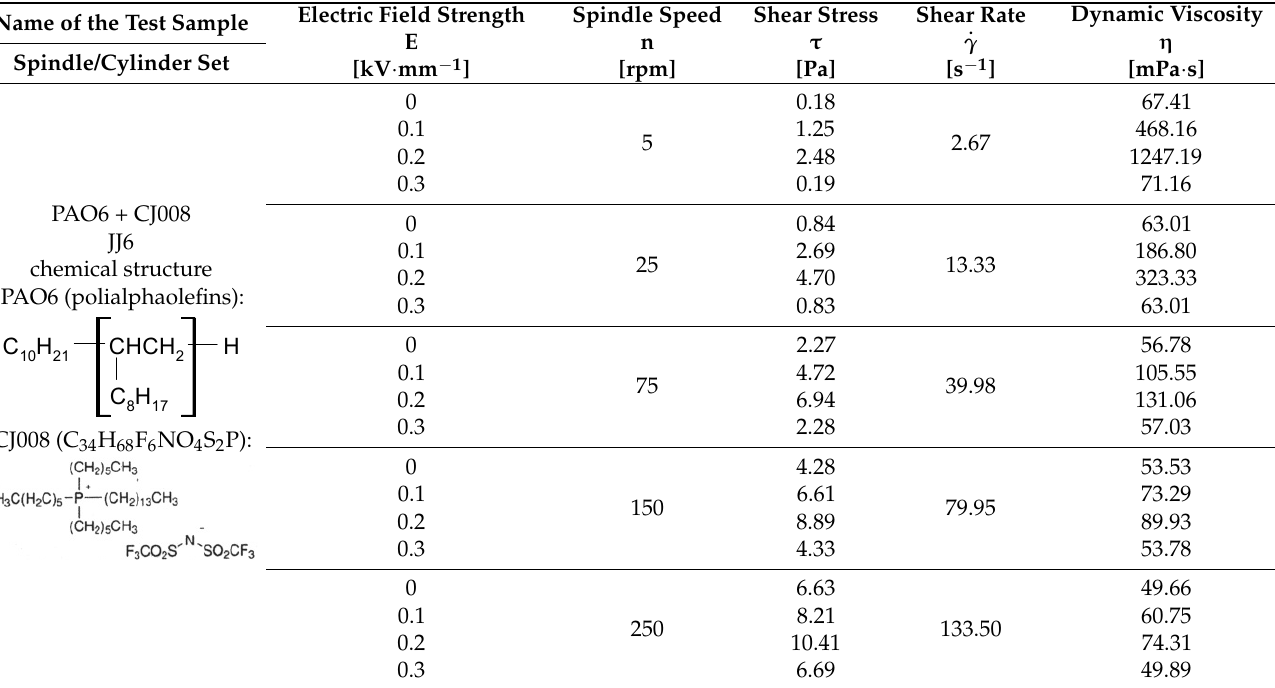
Table 4. Results of research on ER properties of PAO6 + CJ008 mixture.